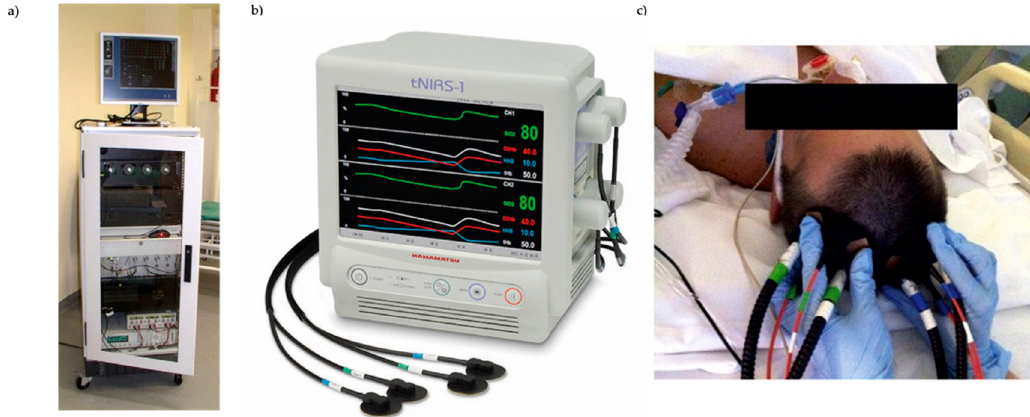
Figure 3. Example of homemade and commercial TD-NIRS instrumentation. ( a ) Homemade TD-NIRS system used in [58], used with ICG. ( b ) The tNIRS-1 commercial system, from Hamamatsu (Japan), courtesy of Hamamatsu. ( c ) Example of probe positioning over both cerebral hemispheres of a patient (the system is the one illustrated in ( a )). Extracted from [58].